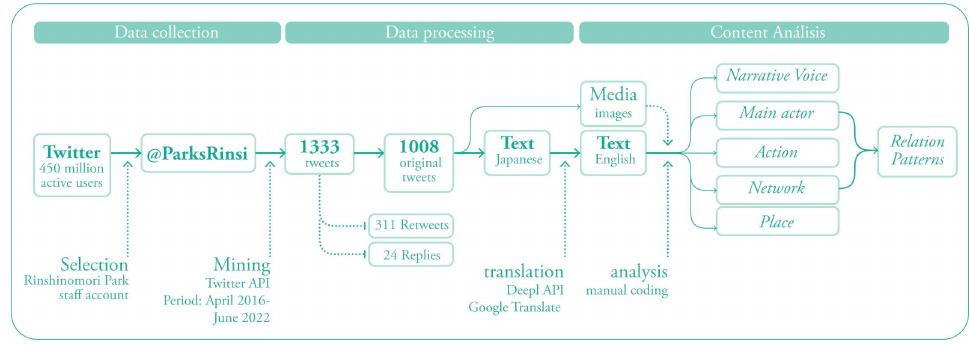
Figure 1. Flow diagram of the methodology.